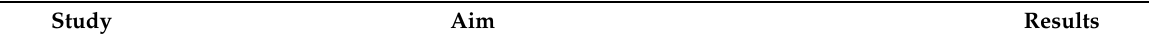
Table 7. Results concerning sleep and